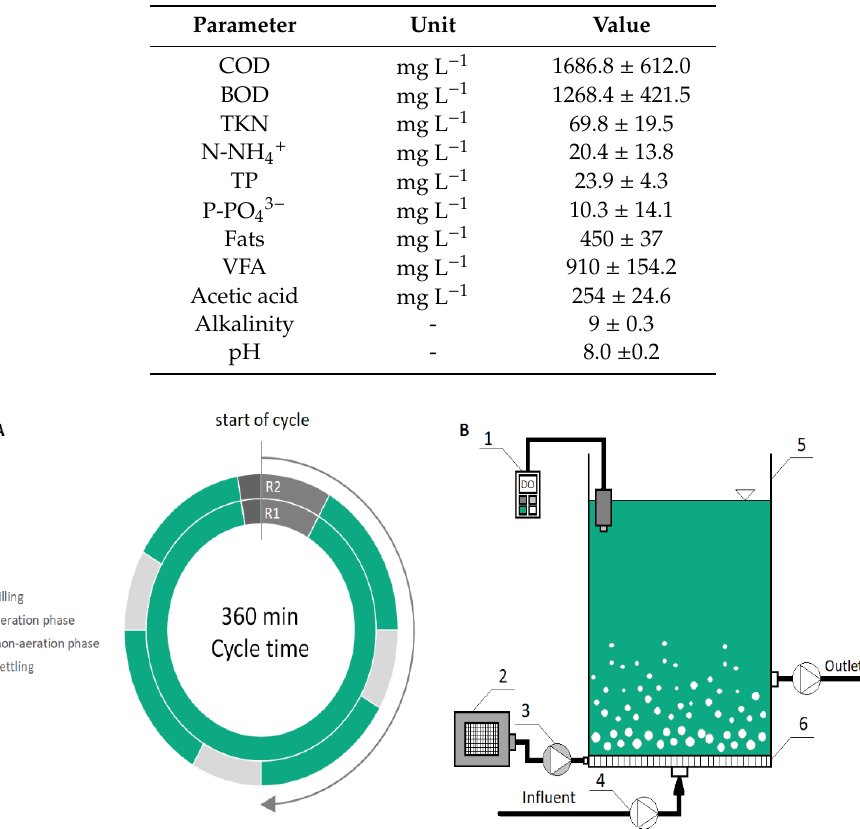
Table 1. The concentrations of pollutants in wastewater from meat processing (COD—Chemical oxygen demand; BOD—Biochemical oxygen demand; TKN—Total Kjeldahl nitrogen; TP—Total phosphorus; VFA—Volatile fatty acids).